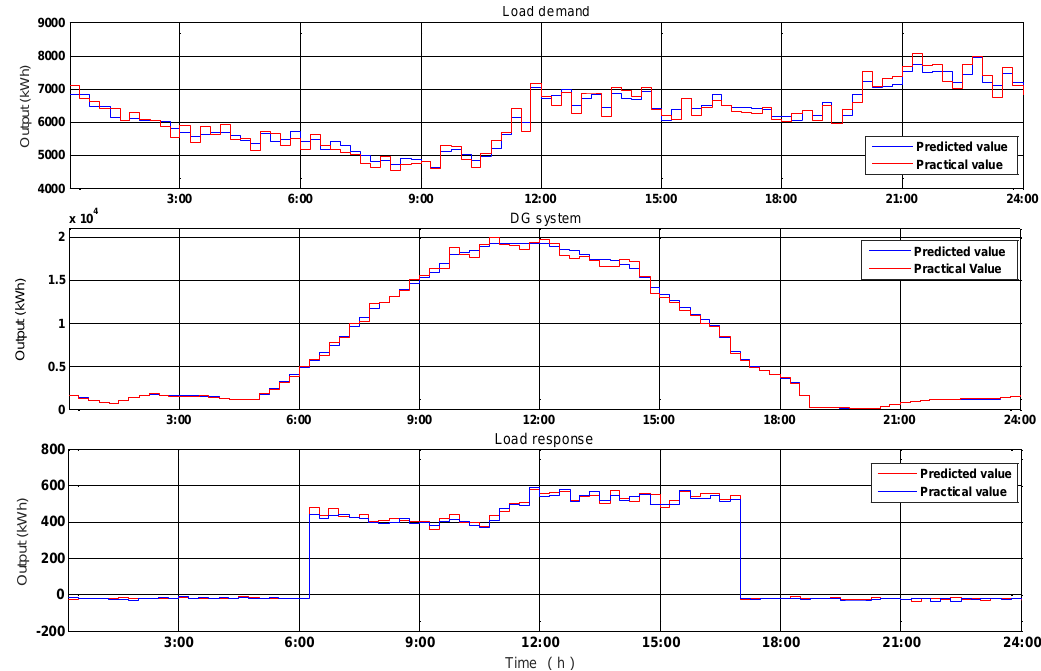
Figure 12. The curves of the actual and forecast daily load demands, response load, and power output by DG system.